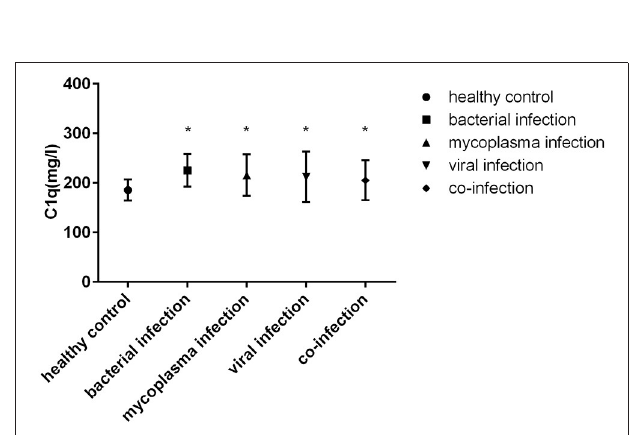
FIGURE 3 | Serum C1q levels in children with sepsis infected by different pathogens. *: Compared with healthy control group, P < 0.05.